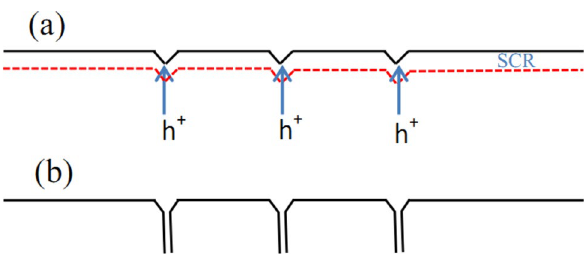
Figure 2. Schematic diagram of etching process. ( a ) Nanopores begin at pits of the InP surface. ( b ) Vertically aligned nanopores are formed in the InP.